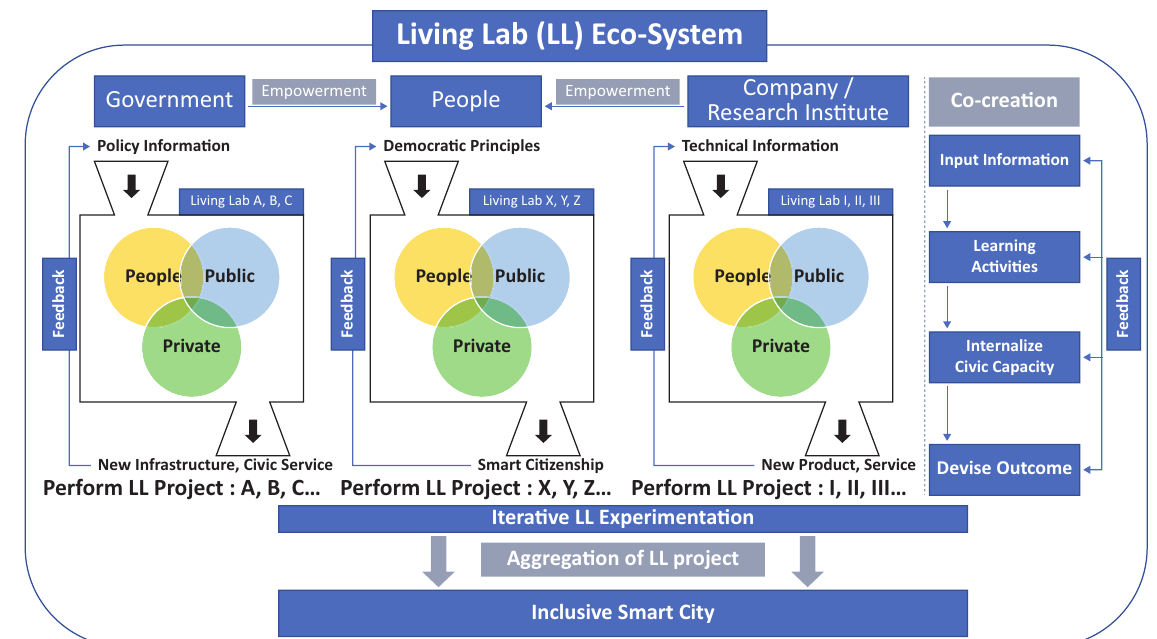
Figure 1. Living lab’s eco‐system and the smart city. the living lab. By learning information and internalizing it into their knowledge, they can enhance their compe‐ tency to enjoy the new smart city service fully. In other words, smart citizenship is nurtured through the learning process in a living lab (Callari et al.,